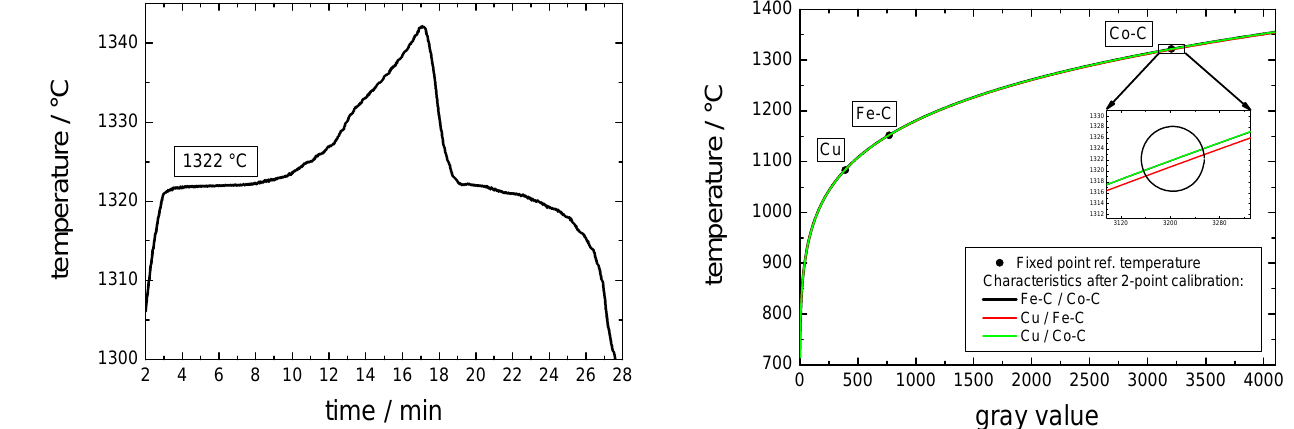
Figure 13. Temperature characteristics of the thermal imaging sys- Figure 13: Temperature characteristics of thermal imaging system after calibration with three 2 tem after calibration with three inductively heated fixed-point cells. inductively heated fixed-point cells, co-axial temperature measurement through zoom laser 3 Co-axial temperature measurement was performed through zoom optics at industrial used machine for job-shop laser hardening (ALOtec Dresden GmbH, 4 laser optics at an industrial machine for job-shop laser hardening (ALOtec Dresden GmbH, Germany). Maximum temperature devi- Germany), maximum temperature deviation over full temperature range: 1.3 K 5 ation over full temperature range: